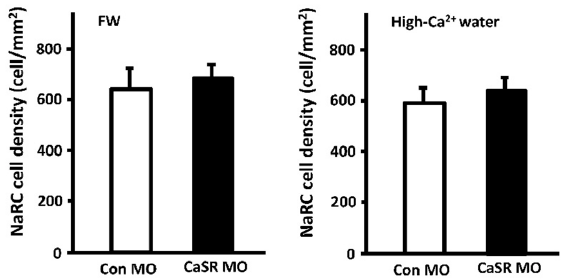
Figure 5. Effect of CaSR knockdown on the density of NaRCs in 3-dpf zebrafish embryos. CaSR and control morpholinos (CaSR and Con MO) [21], respectively, were microinjected into 1–2 cell-stage embryos incubated in normal freshwater (FW) or high-Ca 2+ water (2.0 mM Ca 2+ ). CaSR knockdown did not regulate the density of NaRCs. Cell counting for the density of NaRCs followed the method of previous study [24]. Values are the mean ± SEM. ( n = 12).